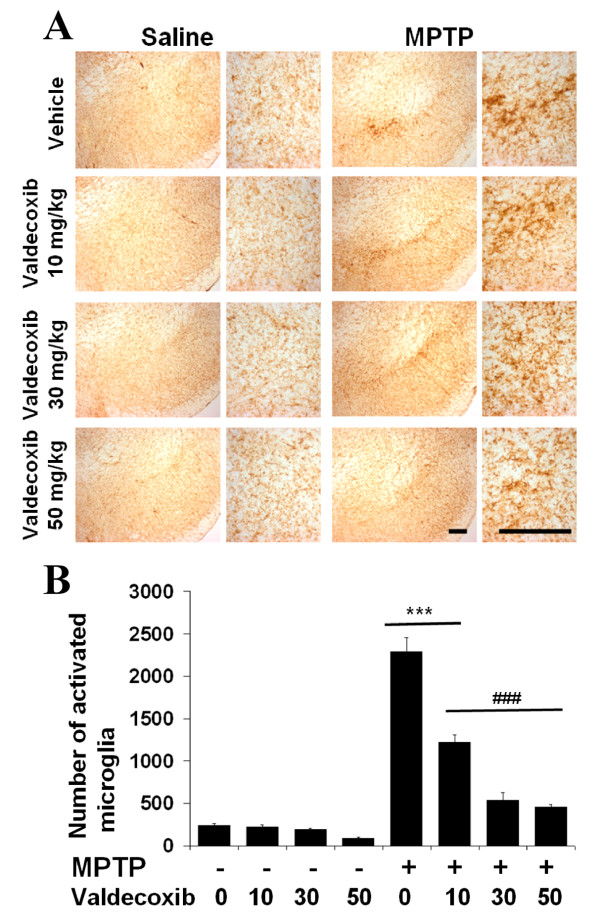
MPTP-induced microglial activation is inhibited by the selective COX-2 inhibitor valdecoxib. A: At 14 days post-MPTP injection, there was a high level of microglial activation in the SNpc. Unlike the vehicle group, mice treated with valdecoxib have diminished microglial activation. Pictures on the right are magnified photographs of the pictures on the left side. In contrast to inactivated striped microglia in MPTP+valdecoxib and control saline sections, activated microglia in MPTP+vehicle sections have a rounder body, fatter processes and denser stain. B: MPTP treatment leads to a significant increase in the number of activated microglia in mice receiving vehicle or the lowest dose of valdecoxib (10 mg/kg daily) but not the higher dose of valdecoxib (30 or 50 mg/kg daily). Activated microglia in the SNpc were bilaterally counted under a 40 × objective. Data are means ± SEM for six to eight mice per group, ***p < 0.001 compared to saline+vehicle group; ###p < 0.001 compared to MPTP+vehicle group, by ANOVA with subsequent Bonferroni for multiple comparisons. Scale bar, 100 μm.